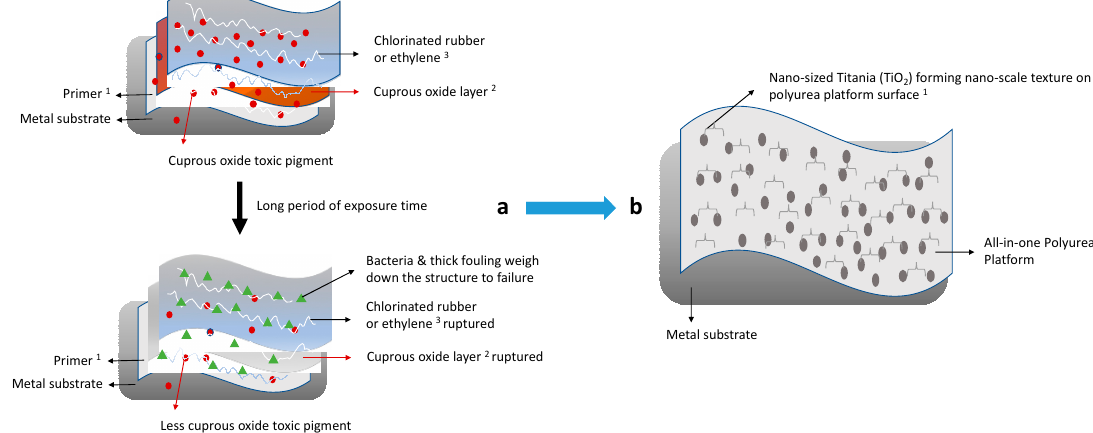
Figure 1. Schematic diagram of typically antifouling paint and all-in-one Titania–polyurea spray coating. ( a ) typically antifouling paint and ruptured structure after long-time exposure, and ( b ) all-